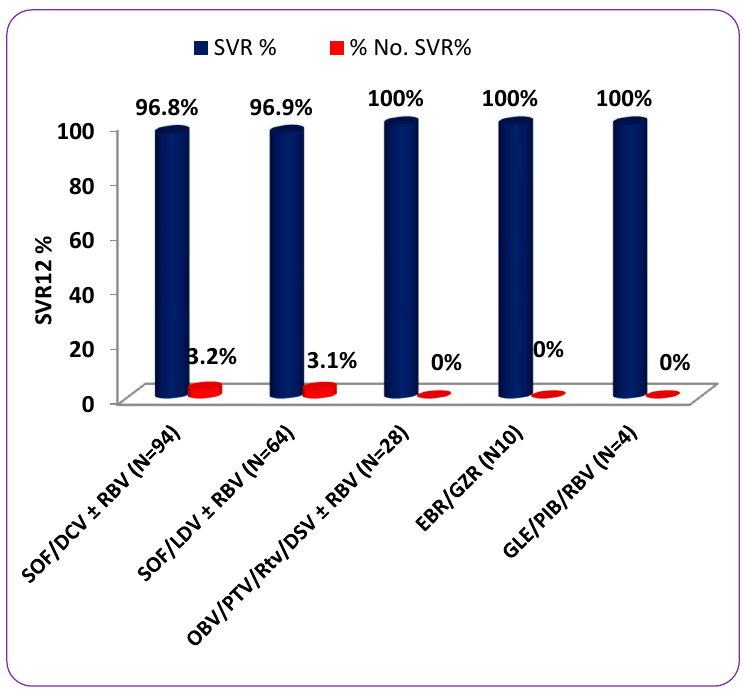
Figure 1. SVR percentage rates stratified by different patients’ characteristics and prescribed drug regimens.